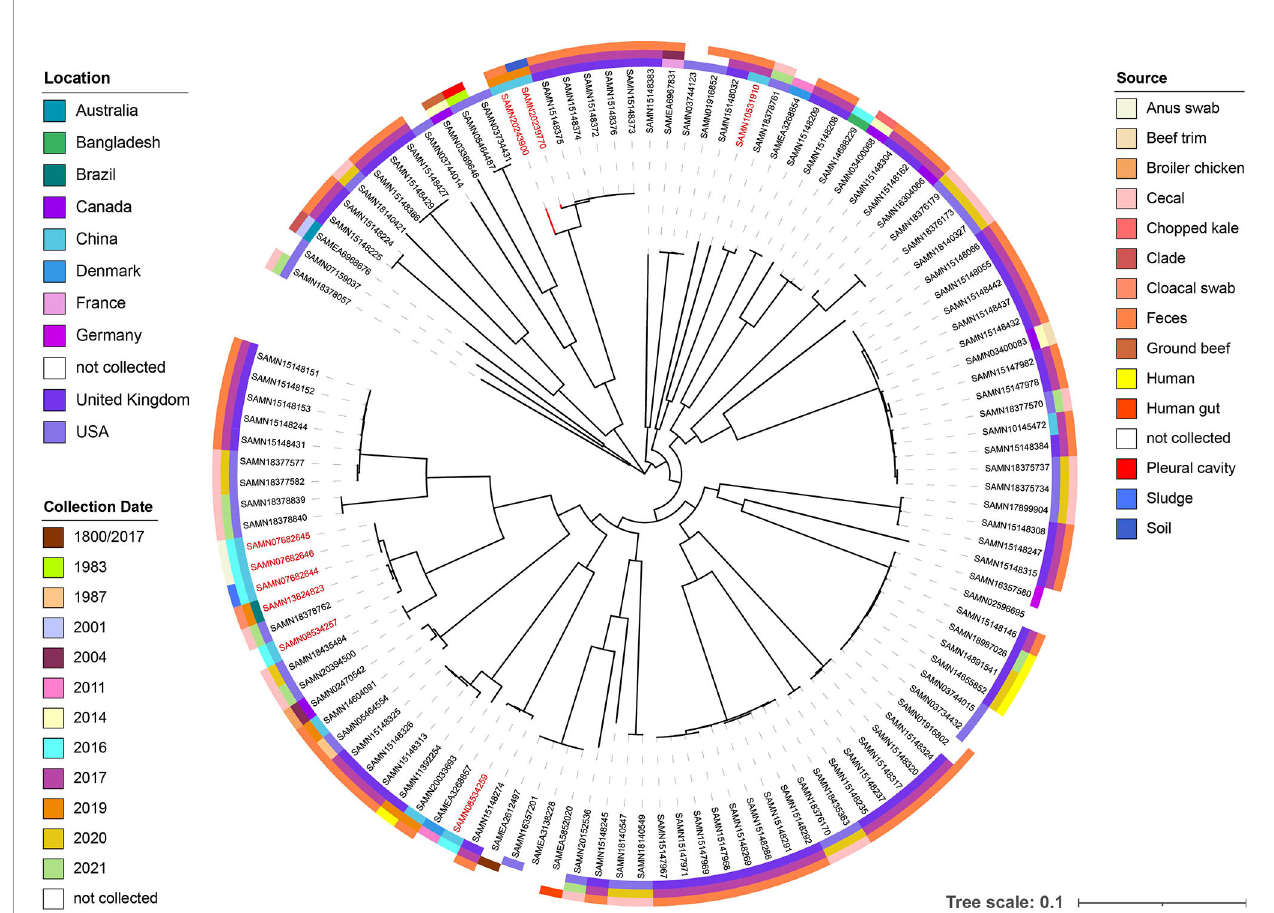
FIGURE 4 | The maximum likelihood phylogenetic tree based on the core genome sequences of 115 E. fergusonii strains. E. fergusonii 6S41-1 (BioSample: SAMN20239770) and 5ZF15-2-1 (BioSample: SAMN20243900) are indicated in red. The other mcr-1 -bearing strains were marked by dark red. The three circles around the phylogenetic tree indicate the location (inner circle), collection date and source (outer circle) of these